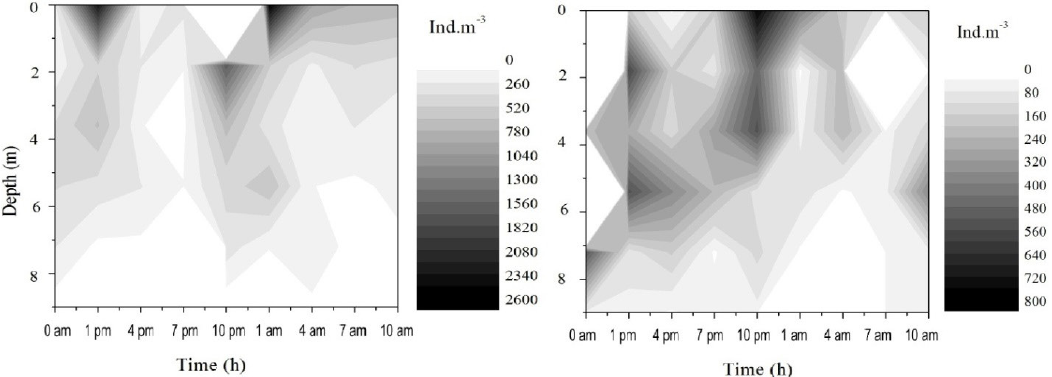
Figure 4. Vertical variation in population density of Bosmina cf. longirostris and Chydorus pubescens (ind.m -3 ) during a single nictemeral cycle, at a study station in Furnas Reservoir, from 10 am of January 15 to 10 am of January 16,